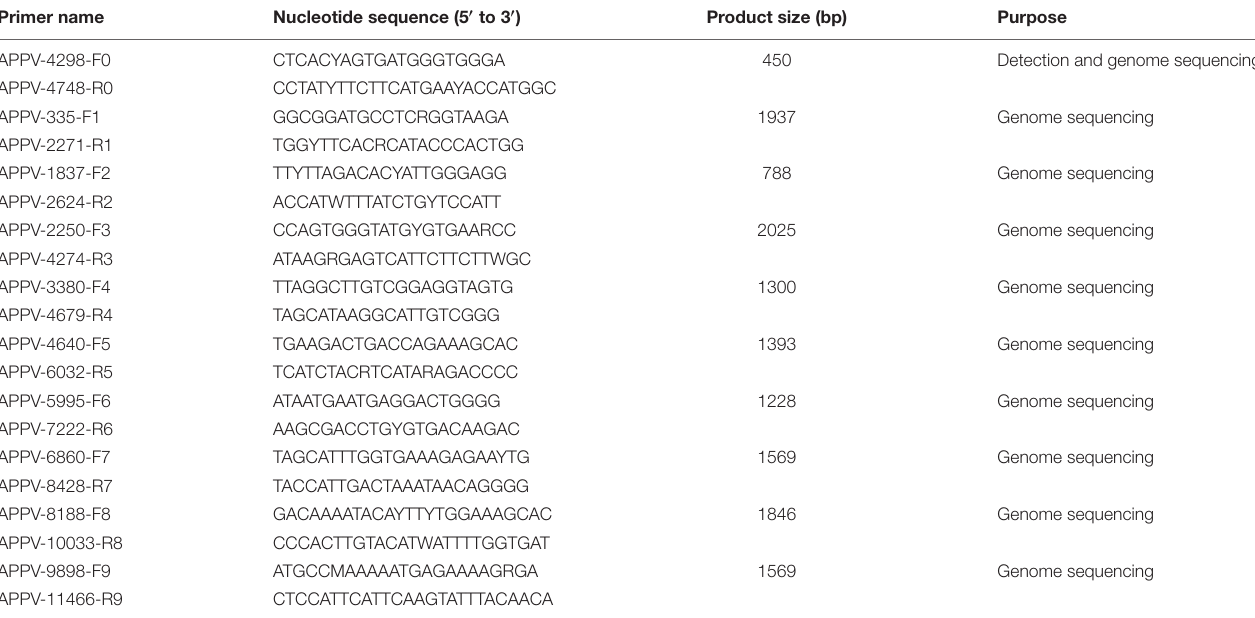
TABLE 2 | Primers used for the detection of APPV and amplification of the complete polyprotein gene. Primer